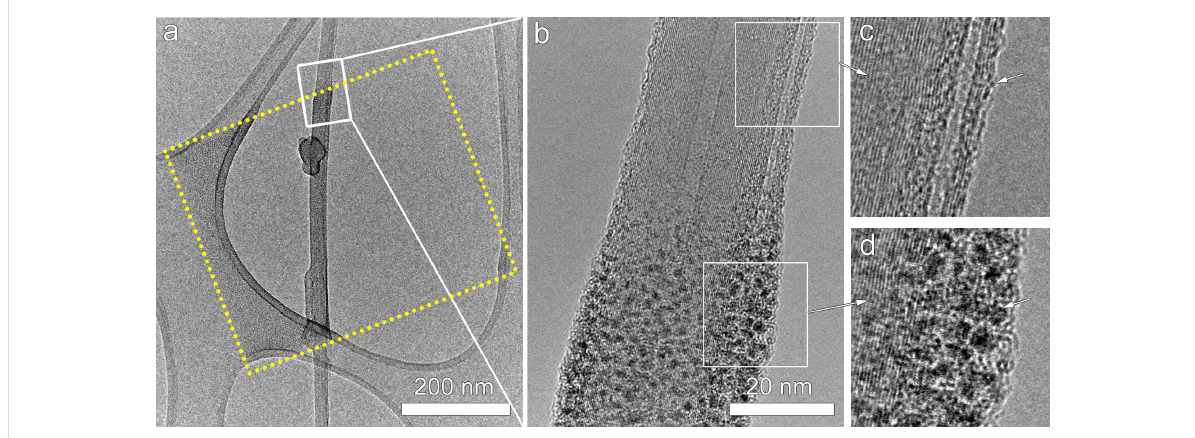
Figure 3: (a) TEM image of Pt nanoclusters deposited by FEBID on a CNT shows that site specific deposition has been achieved. The area indicated by the dotted lines is the predefine area during the deposition process. (b) Shows an enlargement of the rectangular dotted area in (a). The CNT structure has been preserved well during the deposition, as shown by HRTEM images